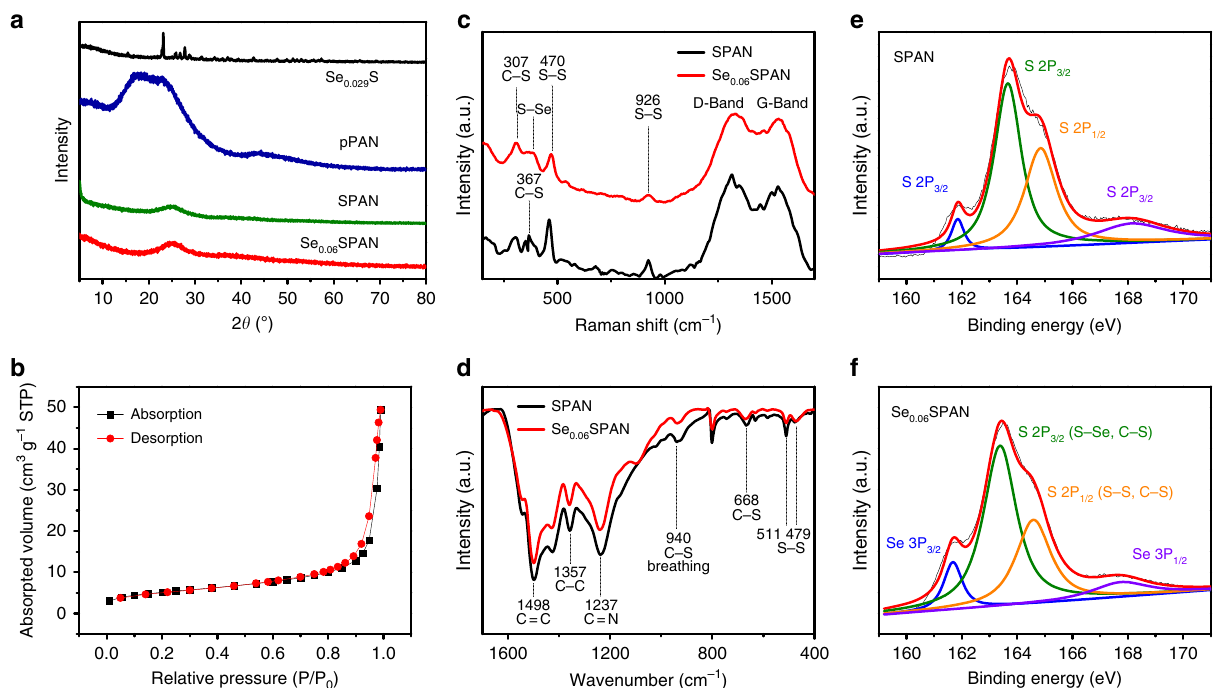
Fig. 2 Materials characterization. a XRD patterns of Se 0.029 S, pPAN, SPAN, and Se 0.06 SPAN. b N 2 adsorption – desorption isotherms of Se 0.06 SPAN. c Raman spectra d FTIR spectra of SPAN and Se 0.06 SPAN. XPS analyses (S2p) of SPAN ( e ) and Se 0.06 SPAN ( f ) composites,